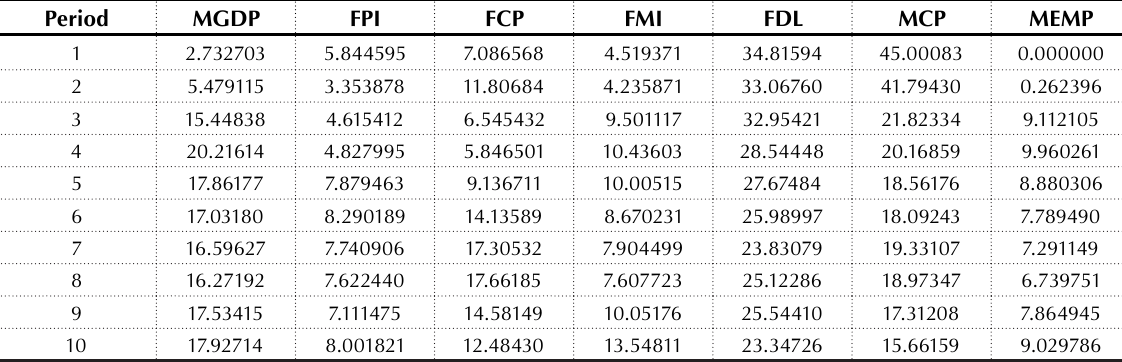
Table A4. Variance decomposition of